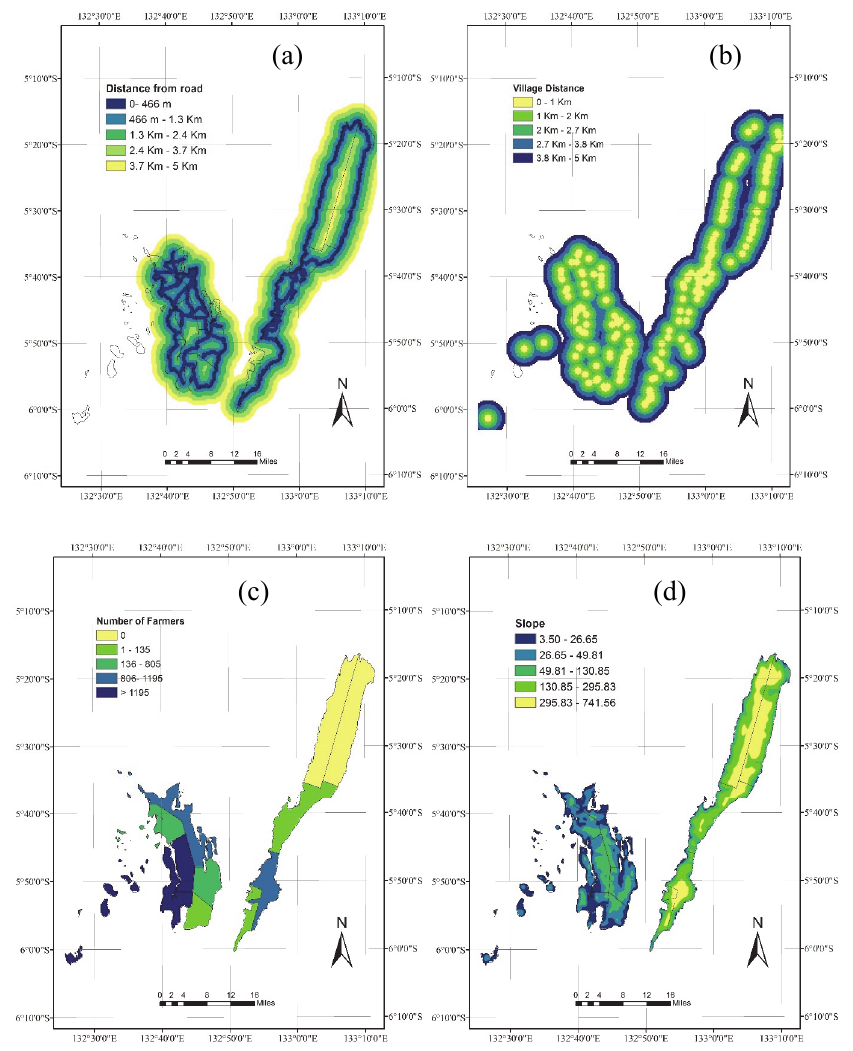
Fig. 5. Suitability Criteria; (a) distance from the road; (b) village distance suitability; (c) suitability map for the number of seaweed farmers in each sub-district; (d) slope